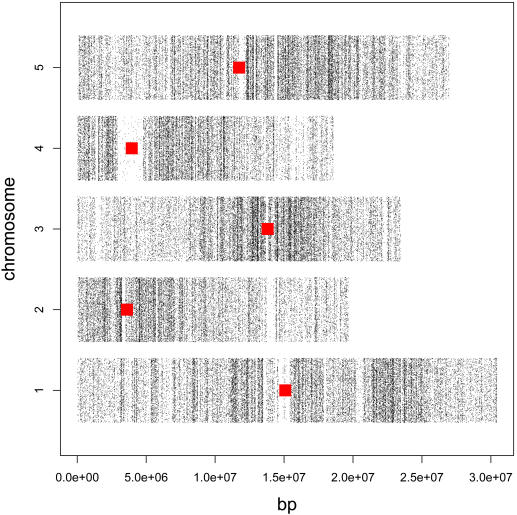
Genomic Distribution of SFPs.The base positions (x-axis) for 120,810 SFPs (FDR 1%) with greater Col intensity were plotted along chromosomes (y-axis). Red bars indicated the positions of BAC clones for centromere sequences (http://www.ncbi.nlm.nih.gov/mapview).